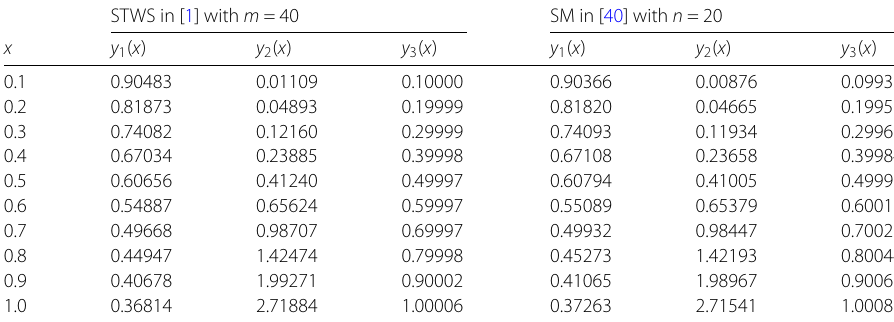
Table 5 Numerical results in references for Example 2 STWS in [1] with m =